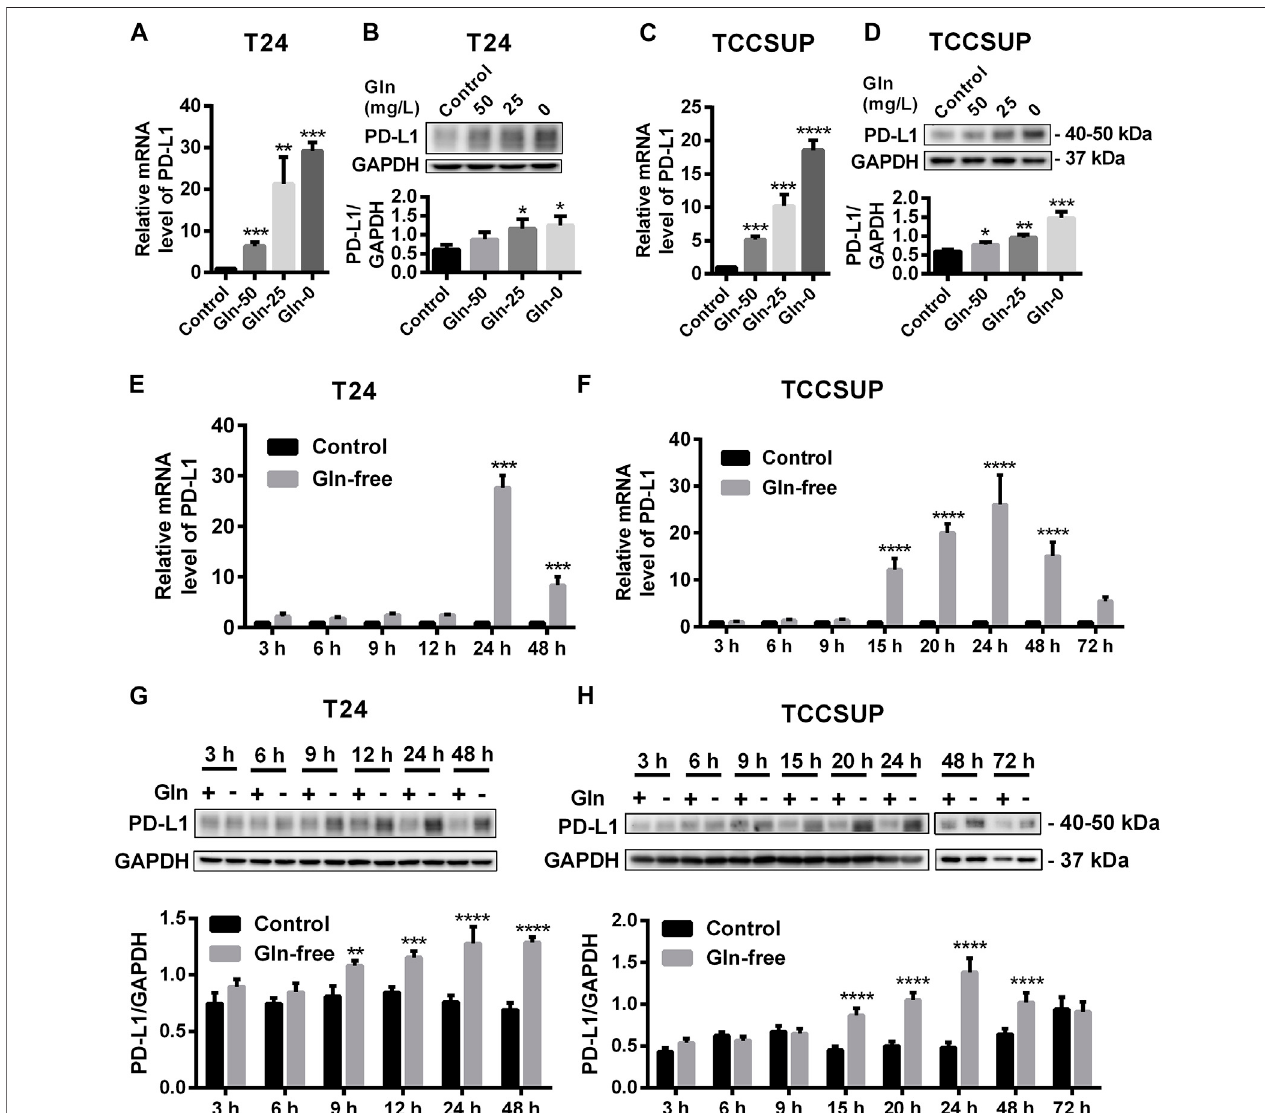
FIGURE 1 | The expression of PD-L1 is upregulated by glutamine deprivation in T24 and TCCSUP cells. (A,B) The mRNA and protein levels of PD-L1 in T24 cells cultured in low-glutamine and glutamine-free medium (Gln 50, 25, 0: 50, 25, 0 mg/L glutamine; Control: 300 mg/L glutamine). (C,D) The levels of mRNA and protein for PD-L1 in TCCSUP cells cultured in low-glutamine and glutamine-free medium. (E,G) The mRNA and protein levels of PD-L1 in T24 cells after culturing in glutamine-free culture medium for 3 – 48 h (F,H) The mRNA and protein levels of PD-L1 in TCCSUP cells after culturing in glutamine-free culture medium for 3 – 72 h. The densitometric analysis of proteins was performed and the results were normalized to GAPDH. The results were considered signi fi cant at p < 0.05 (* p < 0.05, ** p < 0.01, *** p < 0.001, **** p < 0.0001).